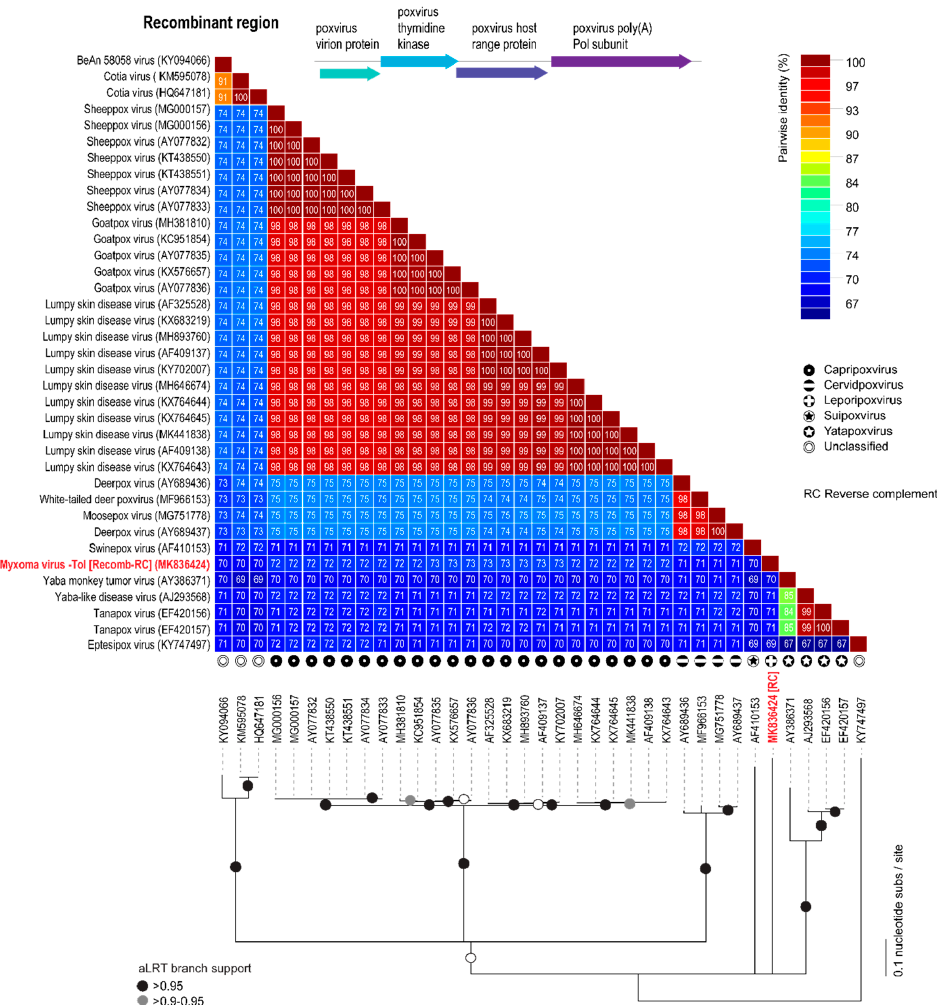
Figure 4. Pairwise nucleotide identity matrix (upper image) and maximum-likelihood phylogenetic tree (model GTR+G+I) showing the relationships of the MYXV-Tol recombinant “four gene cassette” to similar sequences in the genomes of capripoxviruses, cervidpoxviruses, suipoxviruses, yatapoxviruses, and three unclassified poxviruses (BeAn 58058 virus, cotia virus, and eptesipoxvirus). Branches with aLRT support of 0.95 are indicated by black circles whereas branches exhibiting 0.9–0.95 and 0.8–0.9 aLRT supports are indicated by grey and white circles, respectively.